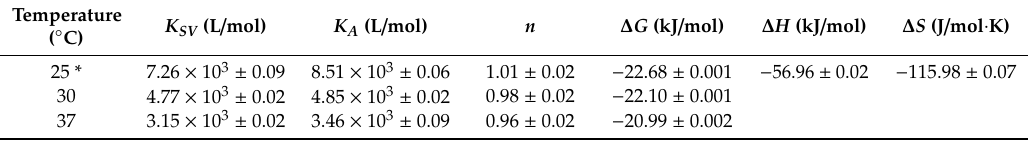
Table 2. Association constants and thermodynamic parameters for the interaction between HSA and TB. Temperature ( ◦